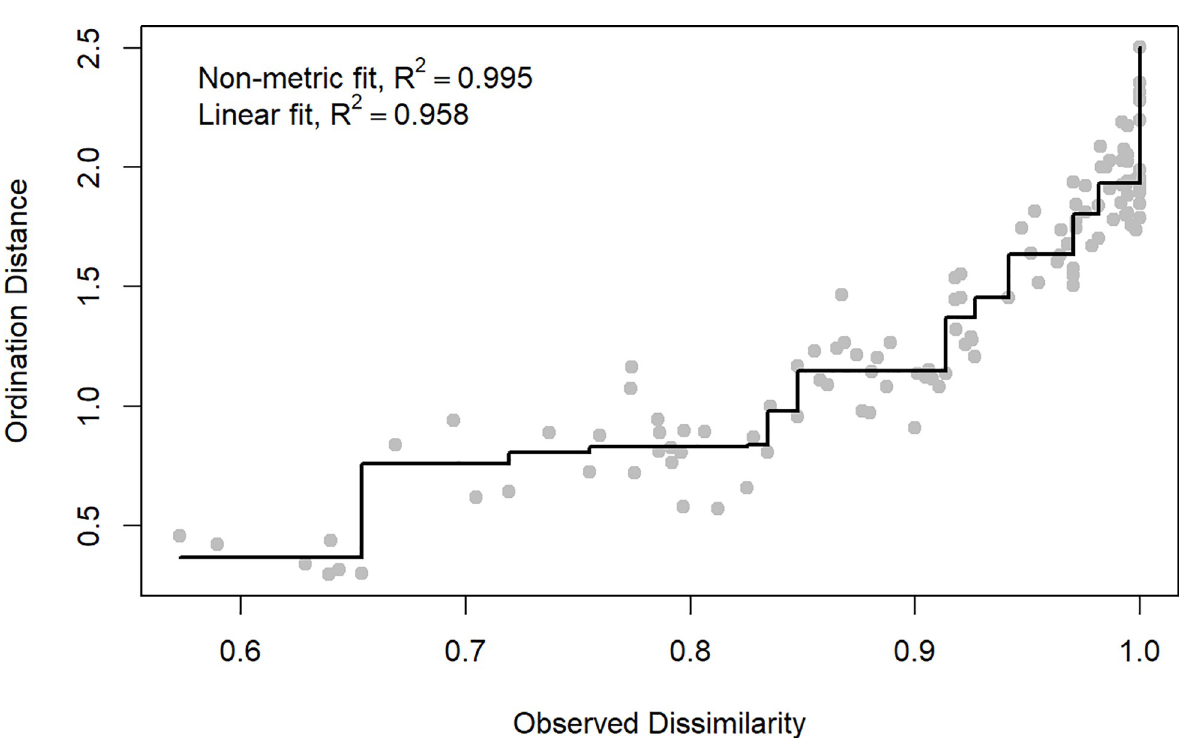
Fig 3. Shepard plot of the NMDS ordination. Shepard plot showing the relationship of the observed dissimilarity with the calculated ordination distance as a measure of goodness of fit.